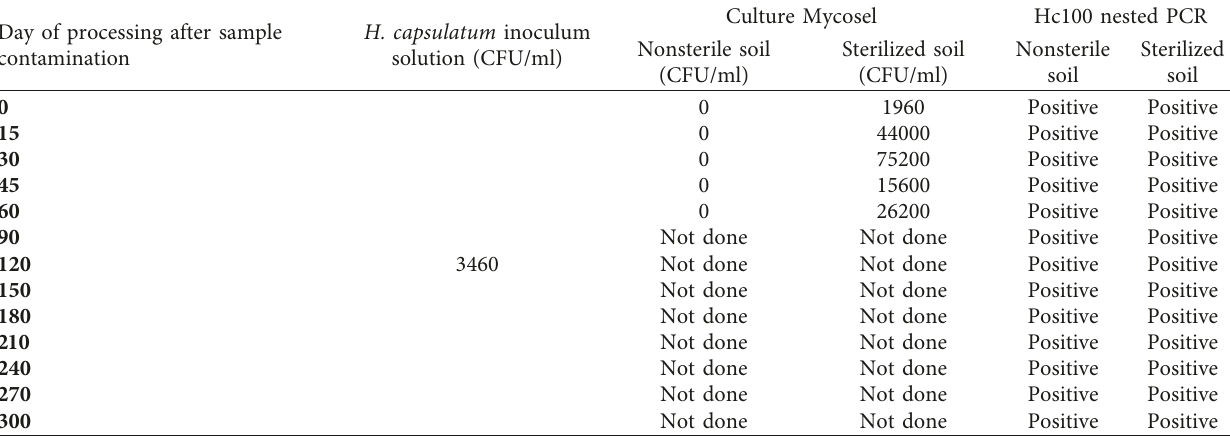
Table 2: Recovery of colony-forming units (CFU/ml) of H. capsulatum from sterile and nonsterilized composted samples contaminated with the fungus.